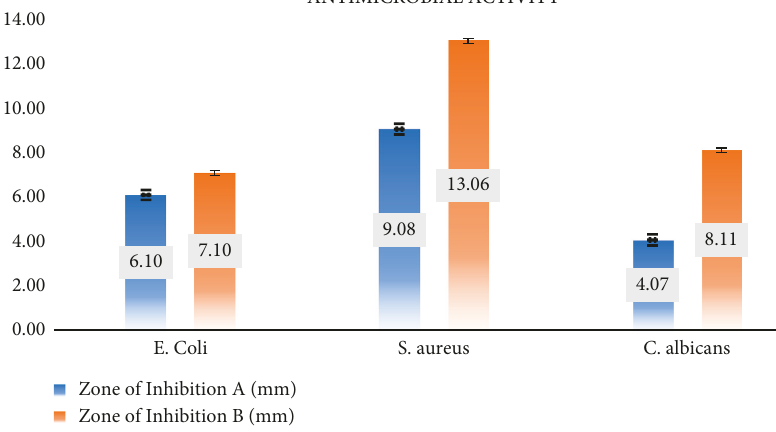
Figure 5: Antimicrobial activity of